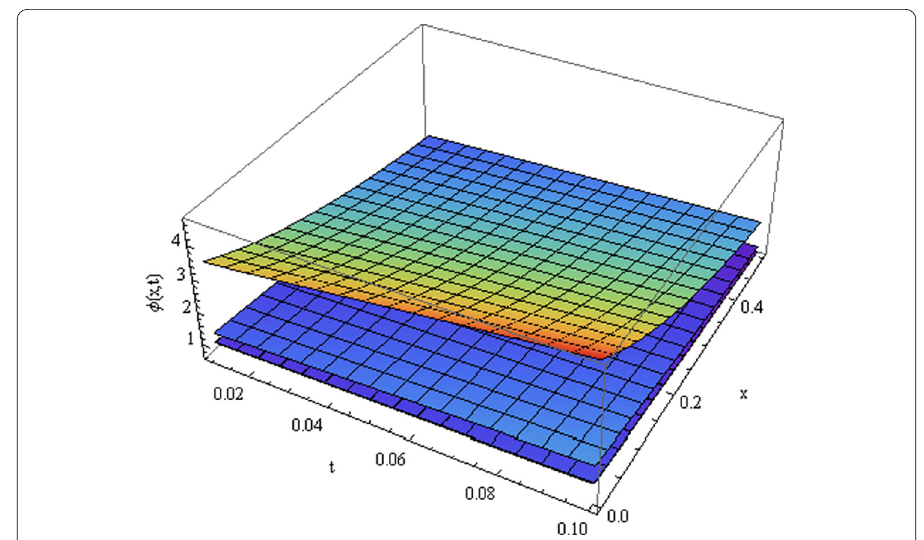
Figure 6 Behavior of the solution with respect to the different values of fractional parameter ( q = 1.0,0.9,0.7 – bottom to top)